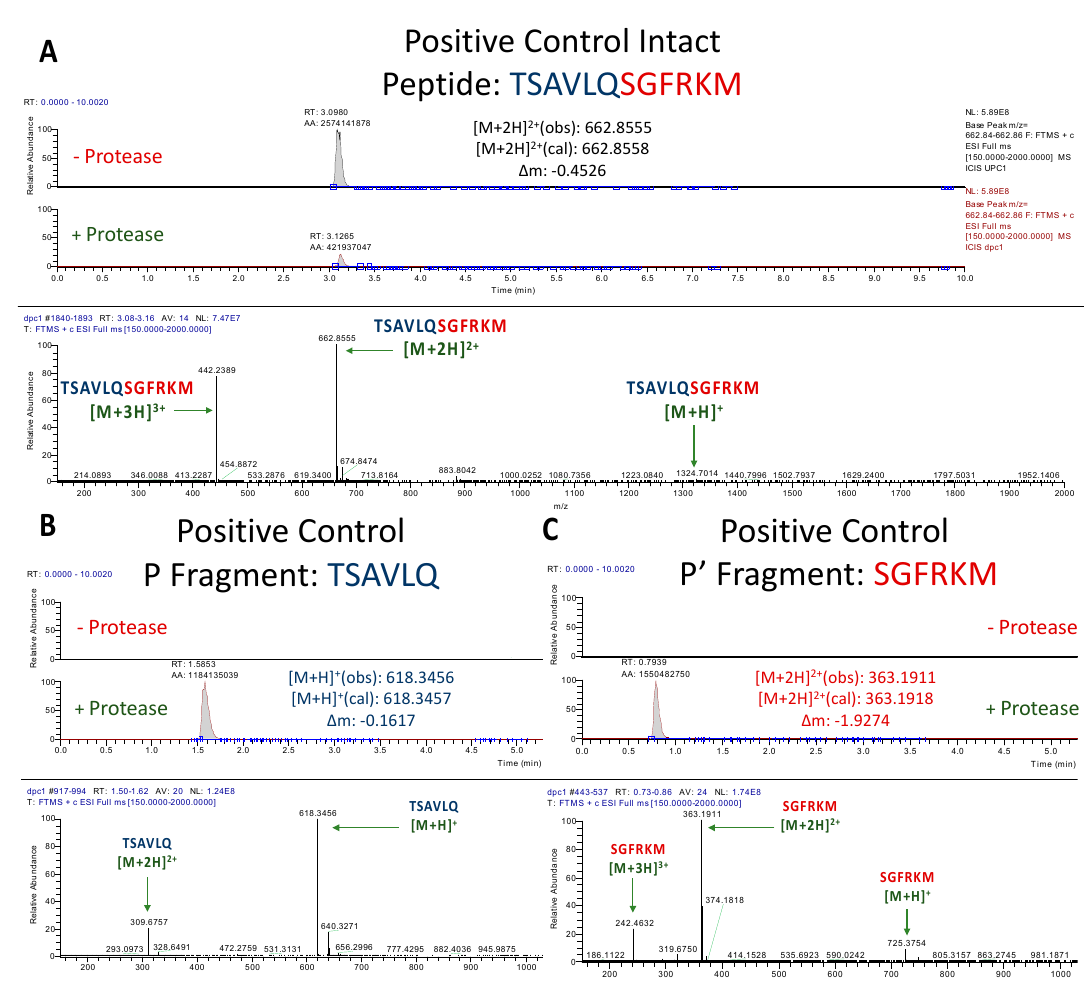
Figure 2. UPLC-MS Data for Positive Control M pro Substrate. Depicted are the extracted ion chromatograms for the samples with and without protease ( top ) and the mass spectra ( bottom ) for ( A ) the Intact Peptide, ( B ) the P Fragment, and ( C ) the P ′ Fragment. The normalization levels of the base peaks for the P and P ′ fragments were 2.39 × 10 8 and 3.99 × 10 8 , respectively. High resolution mass spectrometric analysis corroborates the identities of each base peak in the corresponding extracted ion chromatogram.